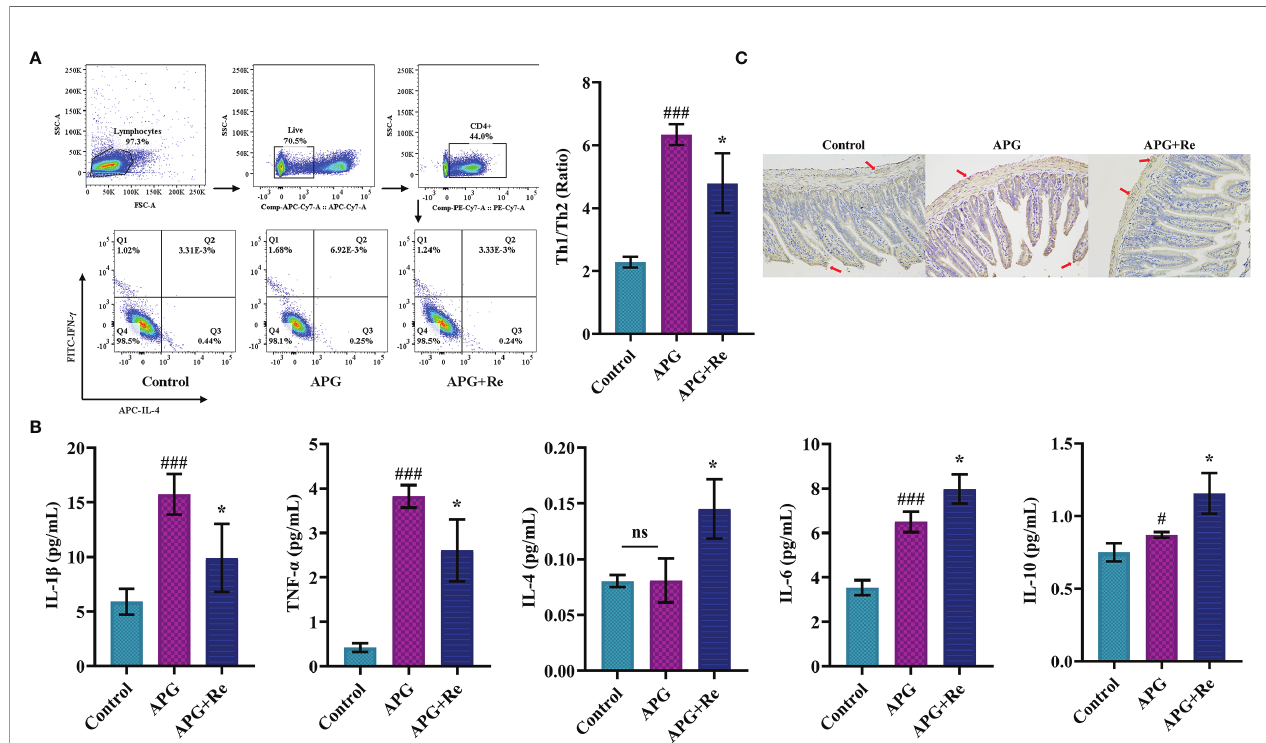
FIGURE 5 | Resveratrol modi fi ed T cell function in mesenteric lymph nodes and jejunum of celiac mice and inhibited expression of characteristic autoantigens in the jejunum. (A) The ratios of Th1/Th2 cells in mesenteric lymph nodes of mice. (B) The expression level of Th1 related in fl ammatory factors (IL-1 b and TNF- a ), Th2 related in fl ammatory factors (IL-4 and IL-6) and IL-10 in the lysate of jejunum tissue. (C) Immunohistochemistry analysis of tissue transglutaminase in jejunum tissue sections. # Indicated statistically signi fi cant differences when compared to the control group. # P < 0.05; ### P < 0.001. * Indicated statistically signi fi cant differences when compared to the APG group. *P < 0.05. (C) were the fi elds of view at 200x lens. ns, no signi fi cant